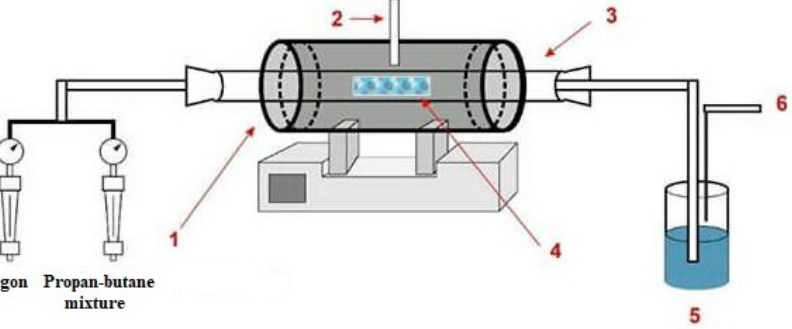
Figure 1. Schematic representation of an experimental setup for the synthesis of MWCNTs. 1—furnace; 2—thermocouple; 3—quarts tube; 4—catalyst; 5—controller of gas; 6—emitted smoke. For the production of carbon nanotubes by the C-CVD method, the diatomite mineral from the Mugaldzhar deposit (Aktobe region, Kazakhstan), presented in Figure 2, was used as a catalyst carrier.